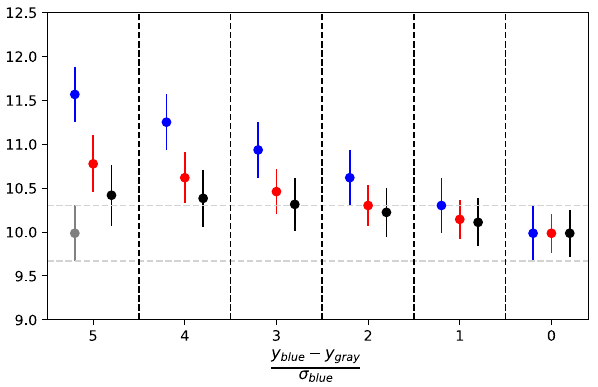
Fig. 8 Neutronlifetimemeasurements.Thegreenpointsaretheresults of bottle experiments, and the blue ones of beam experiments. The discrepancycaneasilybeseen.TheblackpointtotheleftistheBayesian average of the full data, while the first red point is the usual average with the PDG scaling. Similarly for the right black and red points but restricted to the bottle results. The PDG scaling for beam plus bottle experiments is S PDG = 1 . 96, while for bottle only is S PDG = 1 .